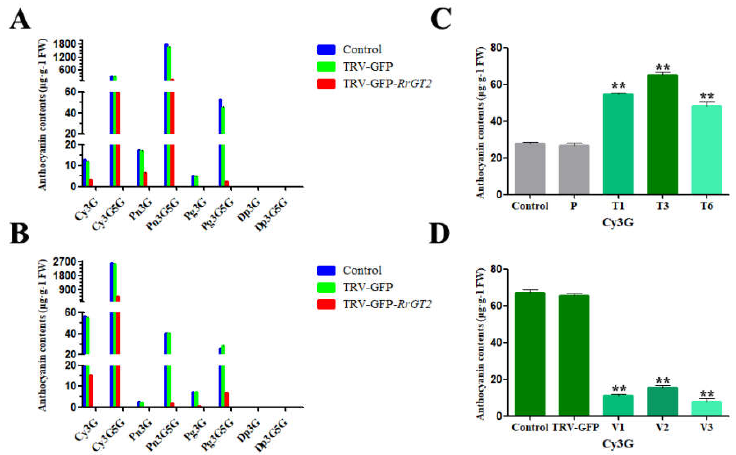
Figure 8. Comparative analysis of anthocyanin components and contents. Anthocyanin components and contents in the flowers of R. rugosa ‘Zizhi’ ( A ) and R. davurica ( B ) subjected to different VIGS treatments. ( C ) Anthocyanin component and contents in the flowers of transgenic tobacco. ( D ) Anthocyanin component and contents in the flowers of transgenic tobacco subjected to different VIGS treatments. ** indicates a significant difference from the control at p < 0.01 according to Student’s t - test.